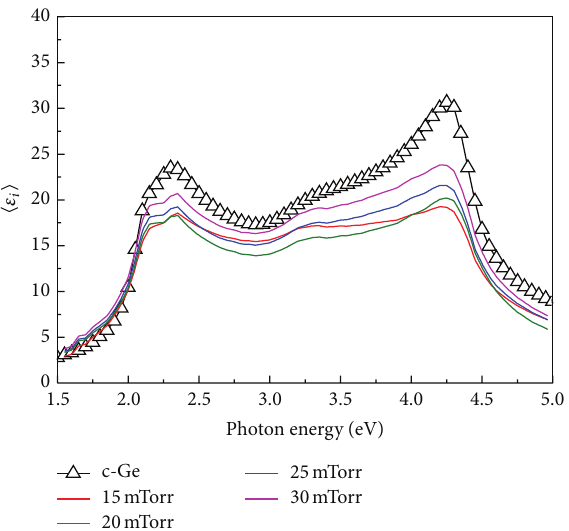
Figure 4: The imaginary part of the pseudodielectric function of Ge epilayers deposited on c-Si (100) substrates for various working pressures as measured by spectroscopy ellipsometry. The spectrum of bulk c-Ge (100) is also displayed as a reference to compare the crystal quality with Ge epilayers.